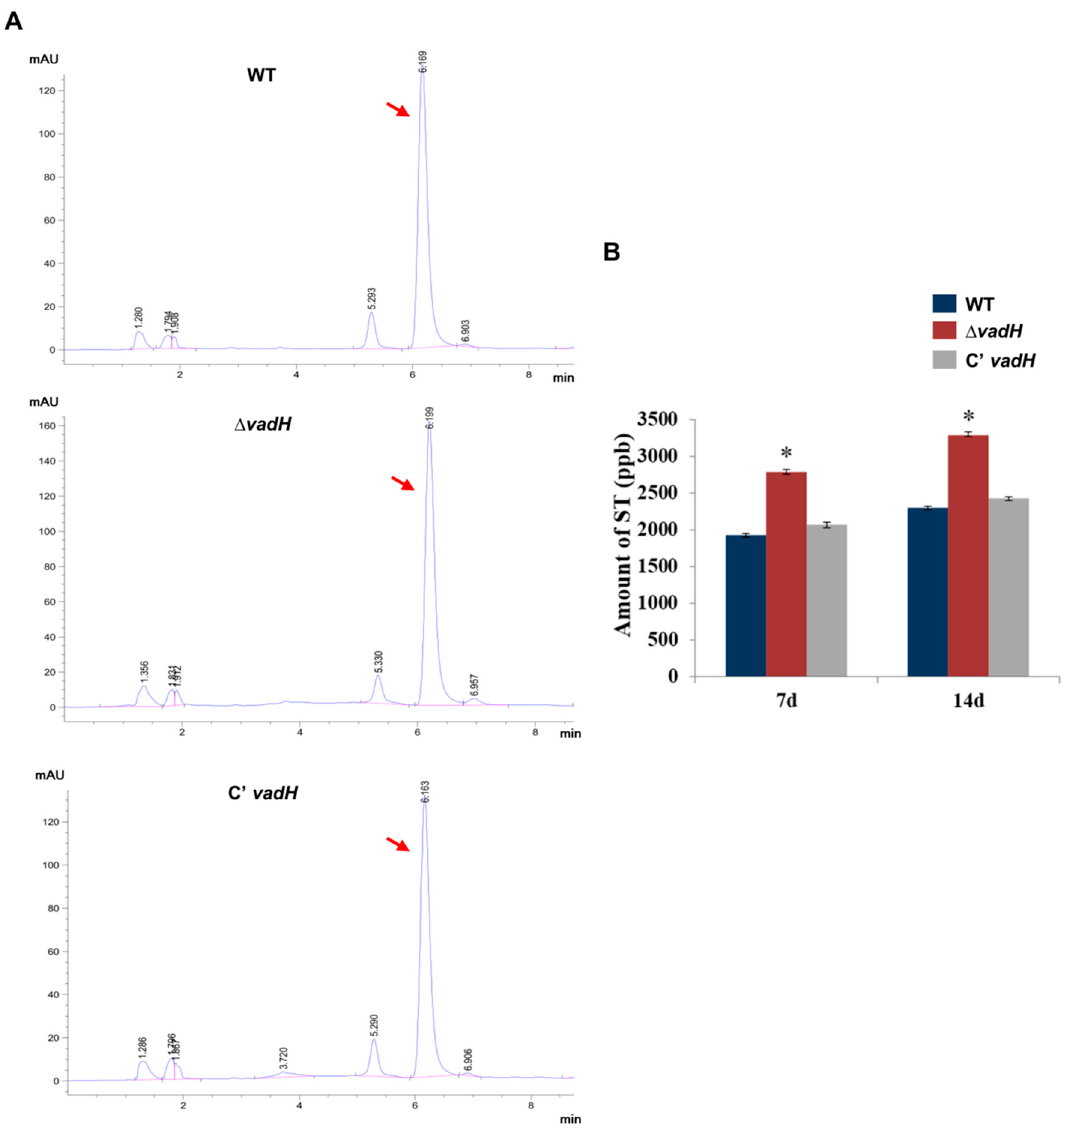
Figure 5. HPLC analysis of ST yield. ( A ) Determination of ST production of WT, Δ vadH and the complemented strain using HPLC. Arrows indicate the peak of ST. ( B ) Statistical analyses of ST yields. The asterisk represents significant level (* p < 0.05).